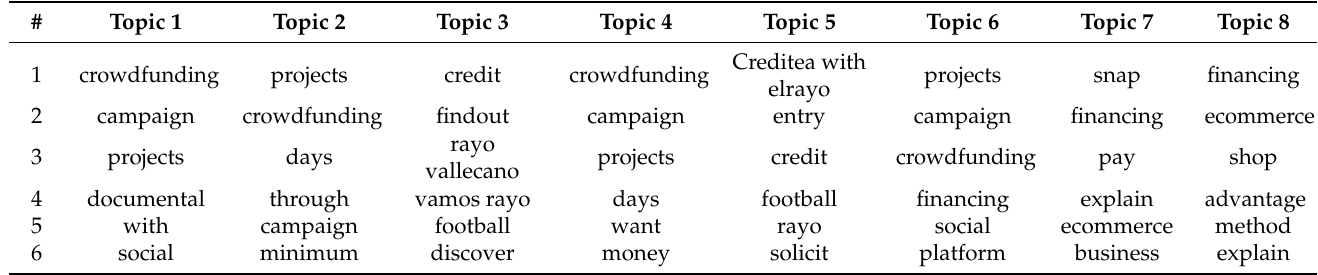
Table 5. Topic modeling results of the lending